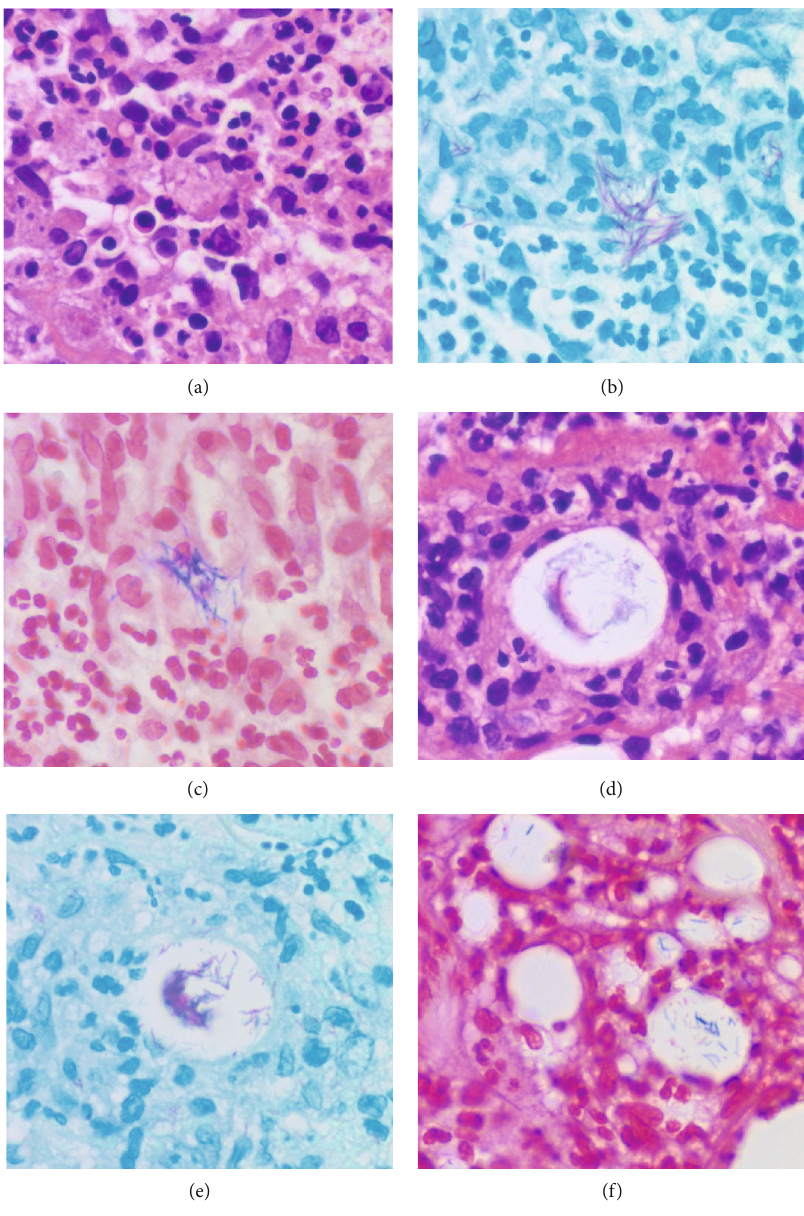
Figure 4: Gram-positive acid-fast bacilli in the second (a – c) and third (d – f) biopsy specimens ((a, d) H&E, (b, e) Ziehl-Neelsen stain, and (c, f) Gram stain). Gram-positive acid-fast bacilli are multifocally clustered in microabscess (a – c) and also in fat droplets located in the center of suppurative granuloma (d – f). The bacteria are visible in the fat droplets even in H&E preparations (d). Such patterns of bacterial colonization are seen in both the second and third biopsy